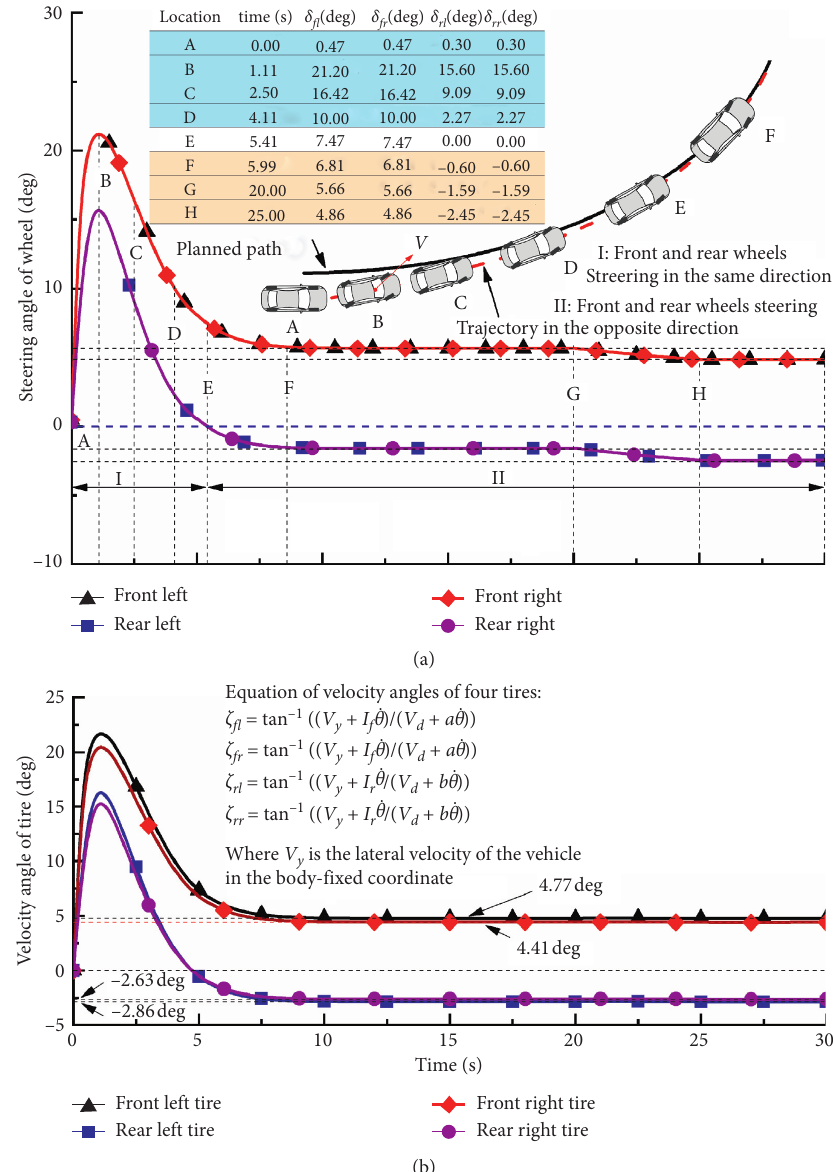
Figure 11: Time histories for wheel steering angles and velocity angles of the vehicle in the circular path-following